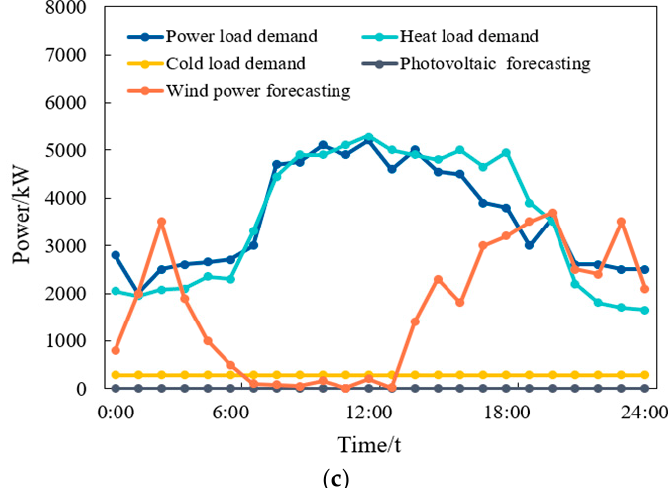
Figure 2. Load parameters and photovoltaic predicted power of each park: ( a ) Utility area; ( b ) Administration area; ( c ) Industrial area.